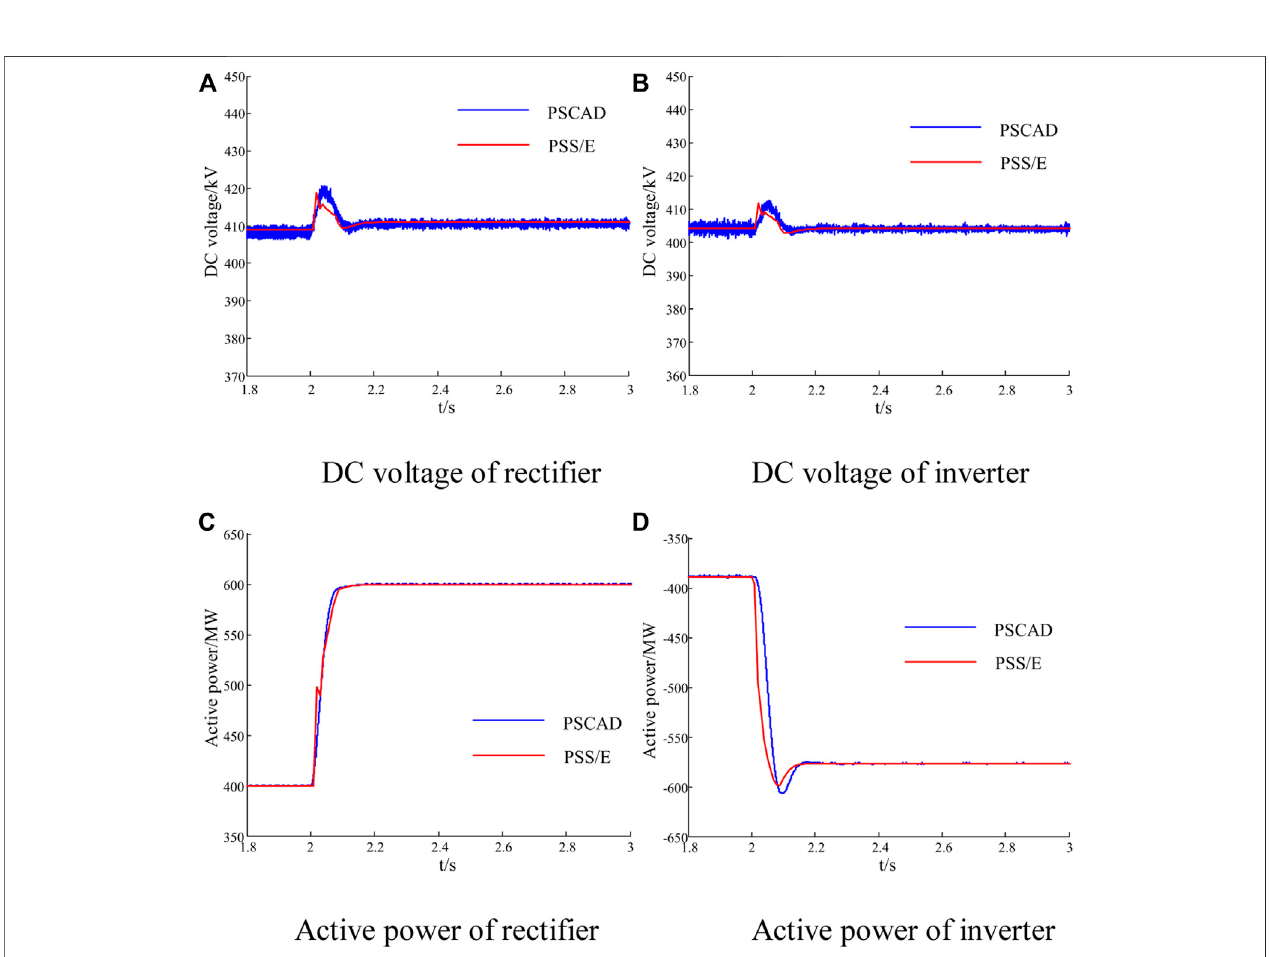
FIGURE 17 | Dynamic response of MMC-HVDC in Case 3. (A) DC voltage of recti fi er (B) DC voltage of inverter. (C) Active power of recti fi er (D) Active power of inverter.